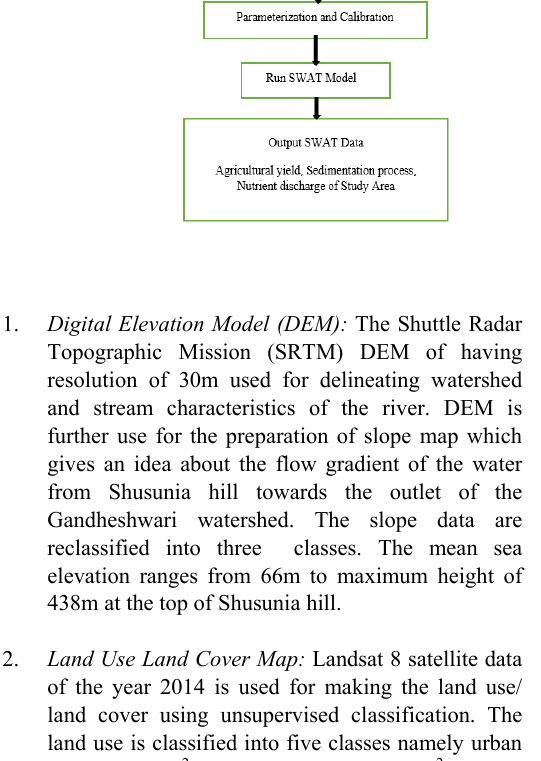
Figure 2. Flowchart of methodology